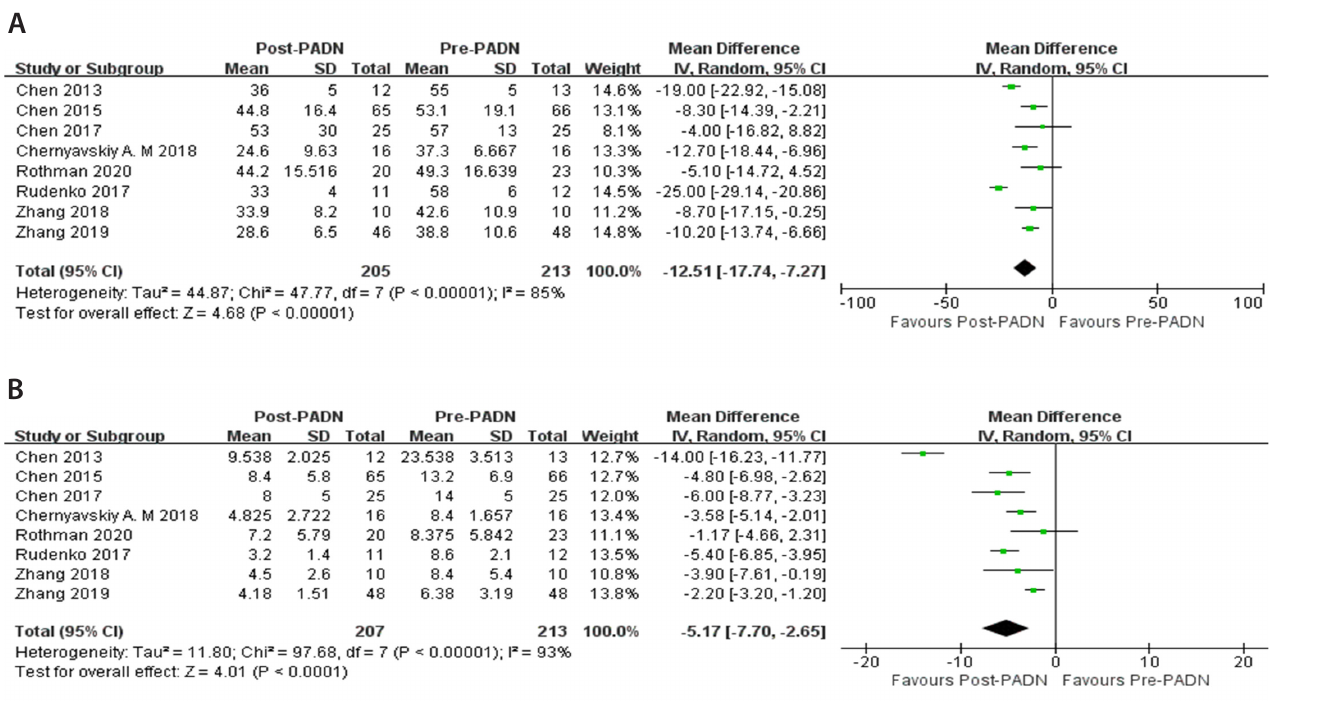
Fig. 3 - Forest plot for comparison of hemodynamic parameters between post pulmonary artery denervation (PADN) period and pre-PADN period: A) mean pulmonary artery pressure (mmHg); B) pulmonary vascular resistance (Wood unit). CI=confidence interval; SD=standard deviation